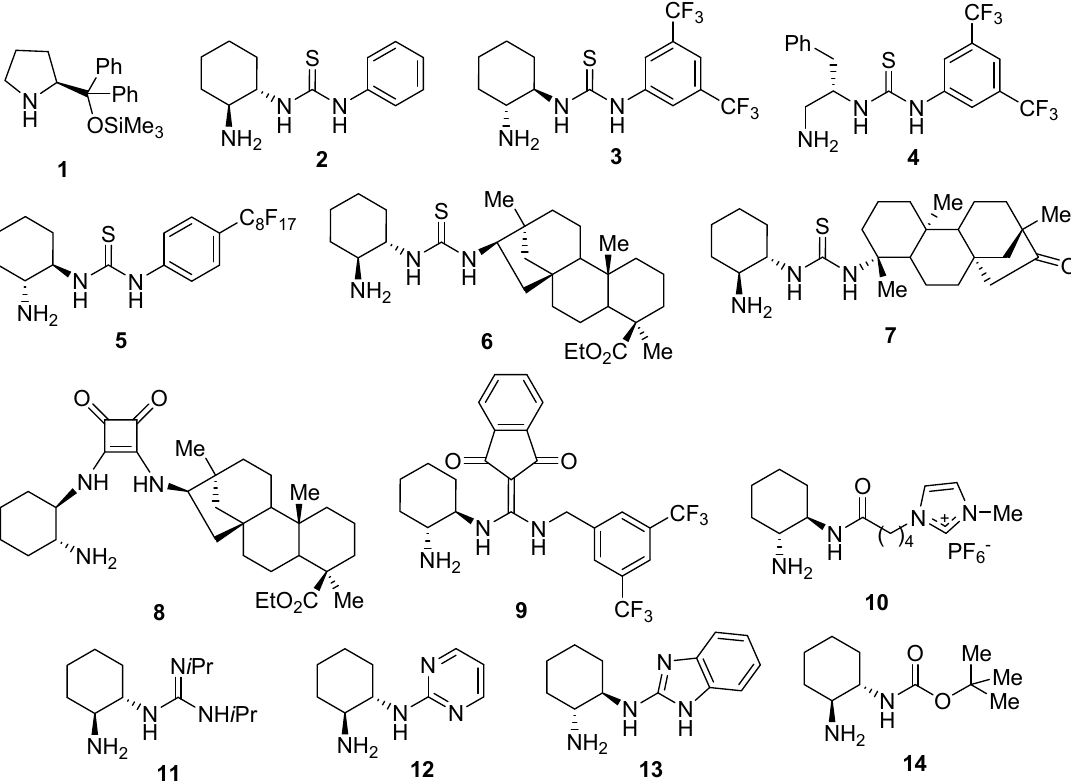
Figure 1. Chiral organocatalysts employed in the enantioselective Michael addition of aldehydes to maleimides.